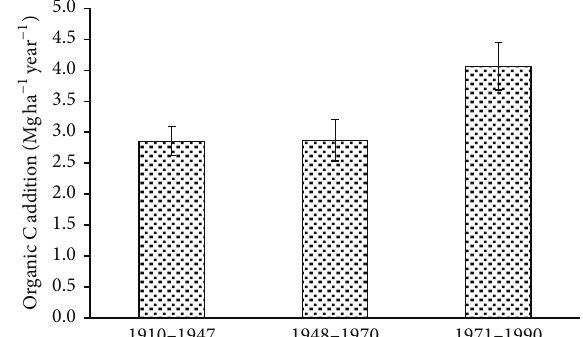
Figure 8: Organic C addition (Mgha −1 year −1 ) from three